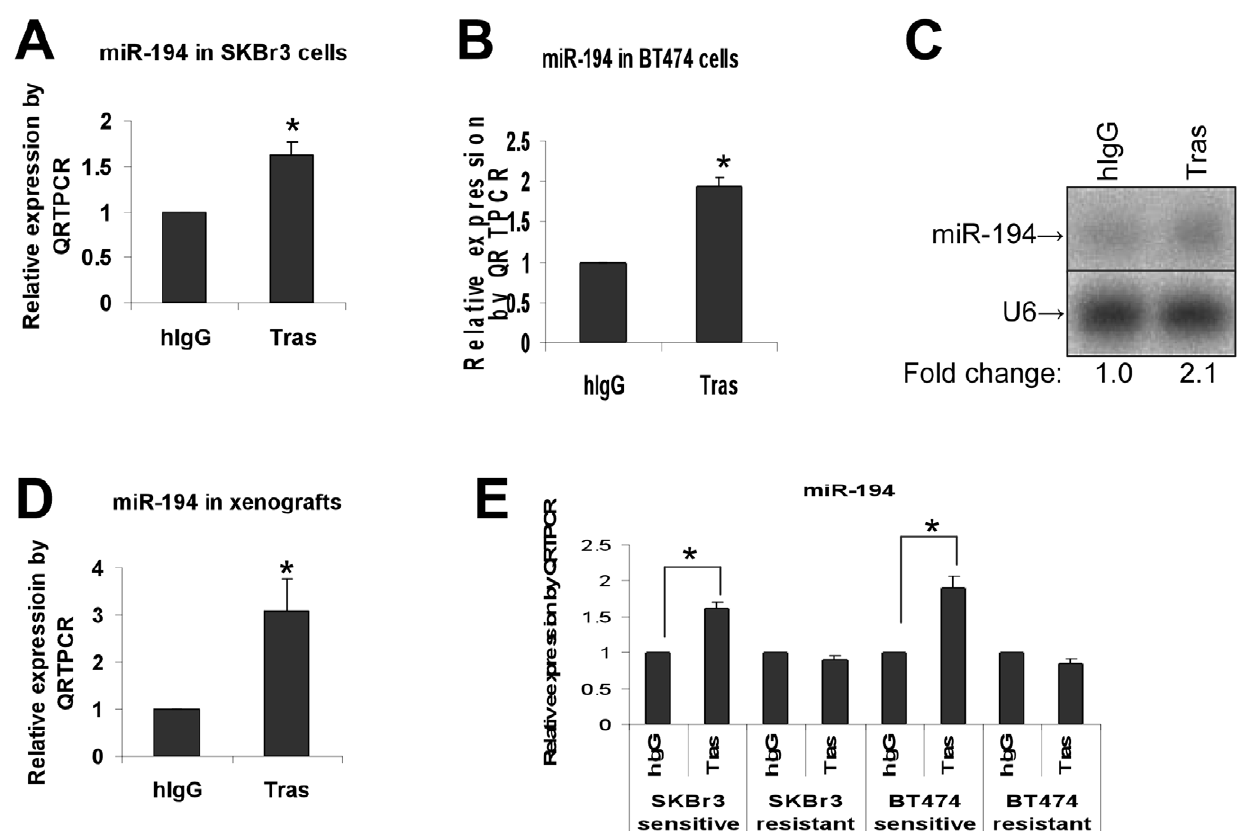
Figure 1. Trastuzumab upregulates miR-194 expression in vitro and in vivo. HER2-overexpressing breast cancer cell lines BT474 ( A ) and SKBr3 ( B ) were treated with trastuzumab (Tras) or control hIgG (10 m g/ml) for 48 hrs. Total RNA was prepared and analyzed by QRT-PCR to measure miR-194. * p , 0.05 compared to hIgG control. ( C ) Northern blot analysis of miR-194 expression. BT474 cells were treated with Tras or control hIgG (10 m g/ml) for 48 hrs. Total RNA was prepared and analyzed by Northern blotting to detect miR-194. U6 non-coding small nuclear RNA (snRNA) served as a loading control. ( D ) QRT-PCR quantitation of miR-194 expression in vivo. BT474 xenografts in miR-194 levels were measured by QRT-PCR. * p , 0.05 compared to hIgG control. ( E ) QRT-PCR quantitation of miR-194 expression in trastuzumab sensitive or resistant cell lines. Parental SKBr3 and BT474 (trastuzumab-sensitive), and their derived resistant cells were treated with Tras or control hIgG for 48 hrs. Total RNA was prepared and analyzed by QRT-PCR to detect miR-194. * p , 0.05 compared to hIgG